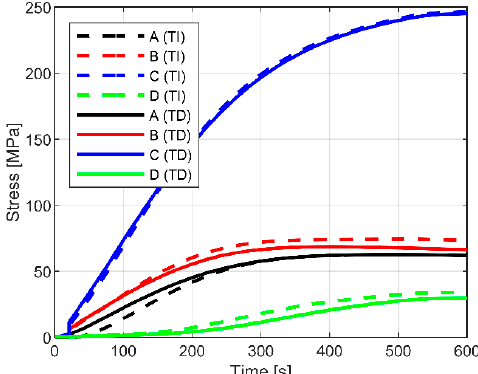
Figure 13. Stress history (at selected control points) for 5 mm glass pane. Notation: D—point in the middle of pane; TI—temperature independent; TD—temperature dependent material properties (ABAQUS/Standard).